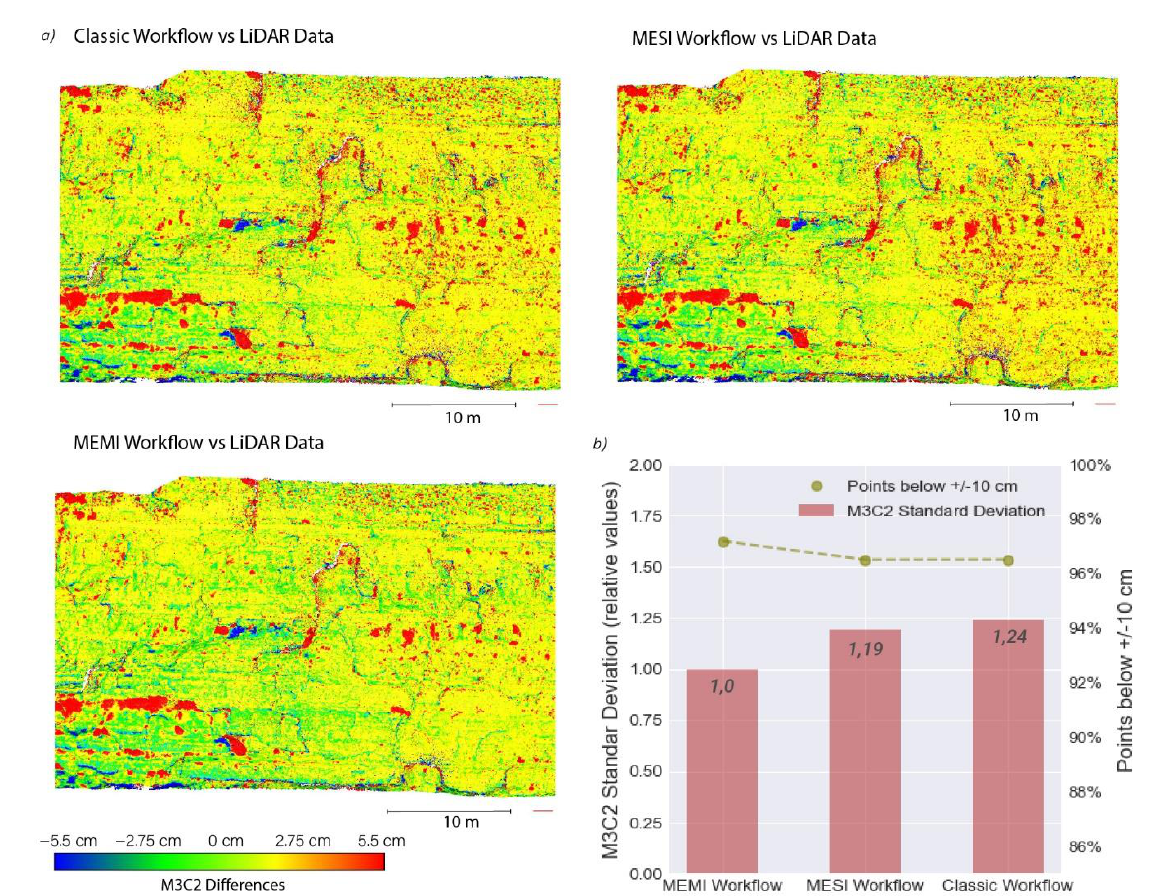
Figure 10. ( a ) Graphic representation of the differences between the LiDAR data (October 2019) and photogrammetry models (November 2019), according to the workflow used. The three models are represented with the same colour map. The larger red clusters indicate rockfalls that occurred during the comparison period. ( b ) Bar plot showing the relative M3C2 standard deviation of the comparisons.